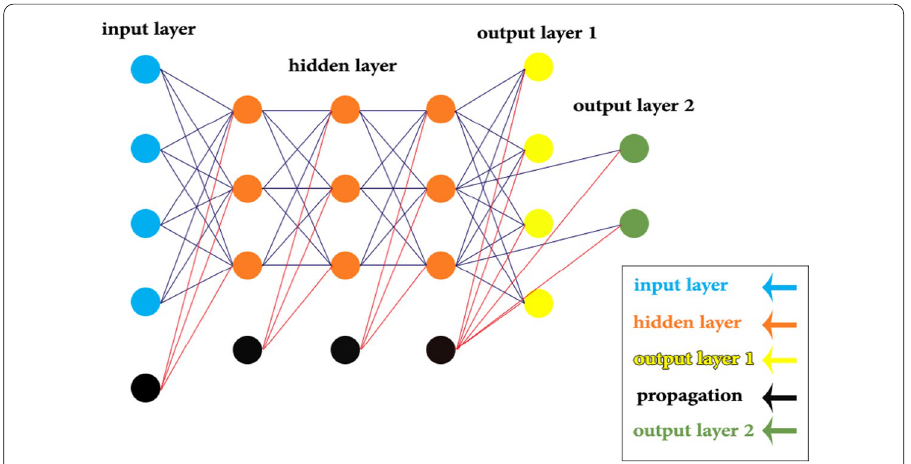
Fig. 2 The basic architecture of deep neural